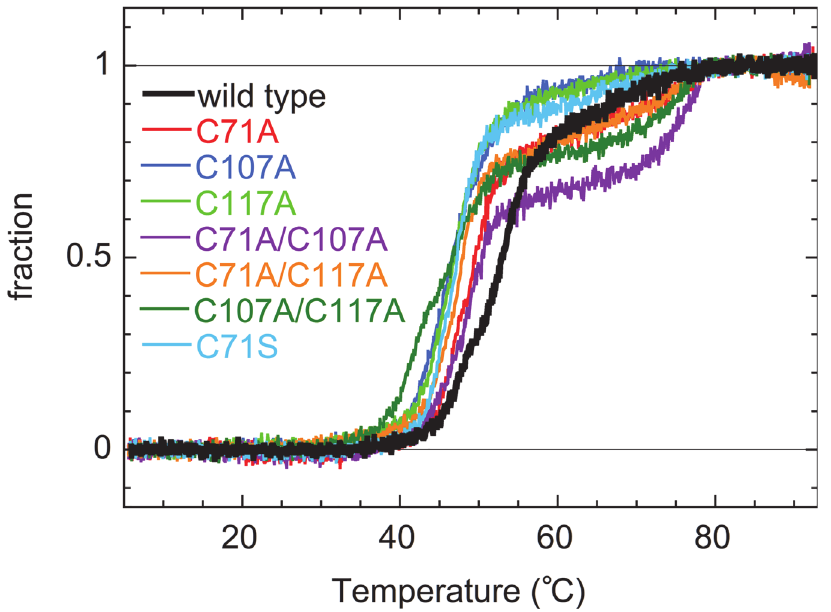
Fig 5. Thermal denaturation curves of the wild type and mutant ADs. The denaturation curves were monitored by the CD ellipticity at 222 nm (S8 Fig). The values were then normalized to the baseline values of the native and unfolded states. A two-step denaturation was observed for the double